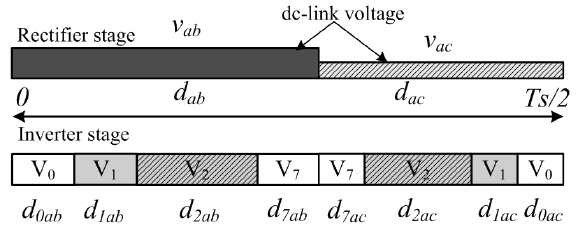
Figure 4. The switching pattern of IMC.